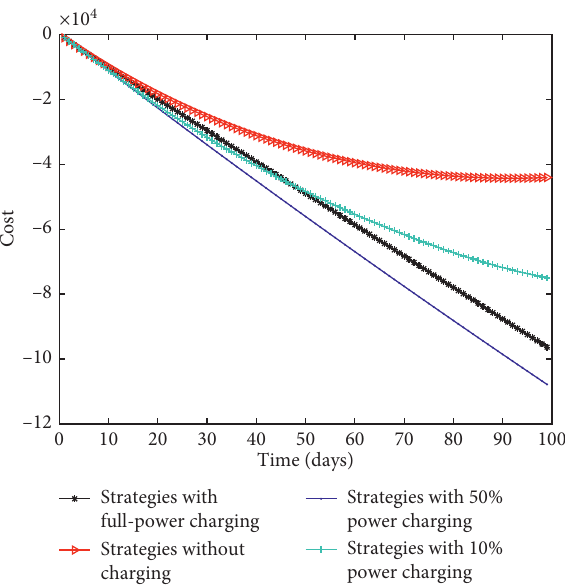
Figure 6: Cost comparison on four cases. The four cases differ in the level of charging power. The corresponding charging power levels of the curve from top to bottom are 0%, 10%, 100%, and